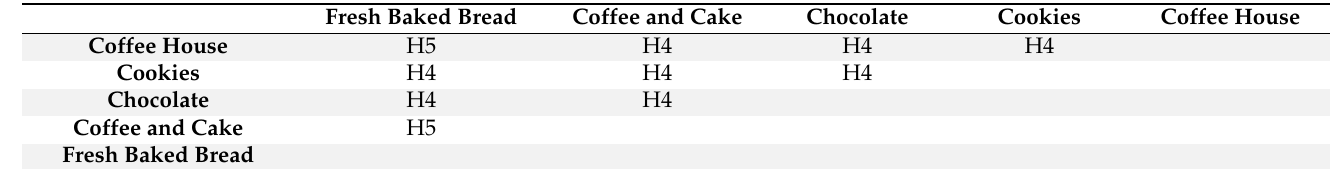
Table 1. Kruskal-Wallis test—comparison of the valence of individual aromas.